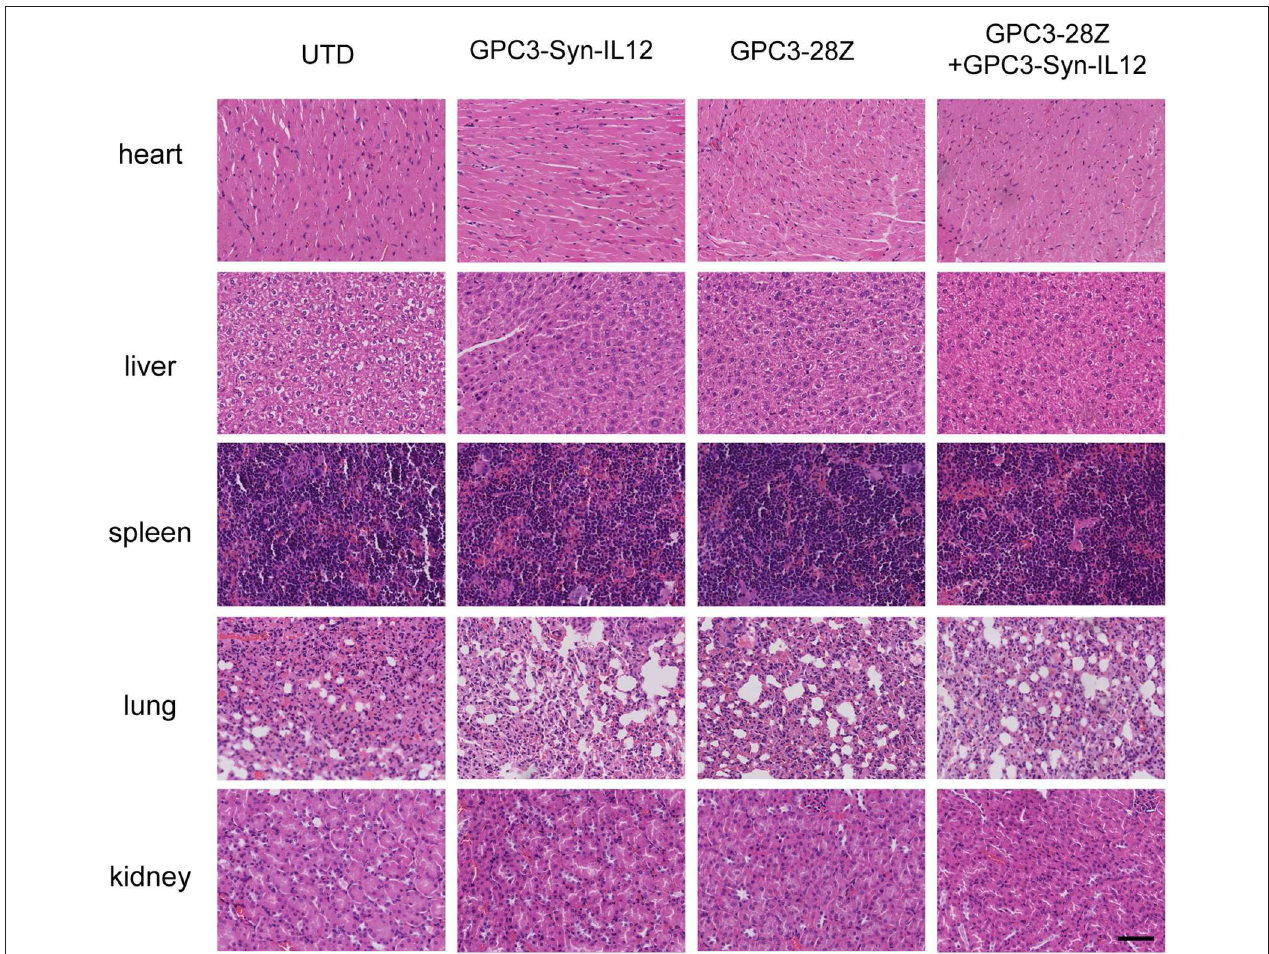
FIGURE 6 | Haematoxylin and eosin (HE) staining of important organs. Organs, including heart, liver, spleen, lung and kidney, were analyzed by HE staining. The specimens were harvested from Huh7-bearing mice sacrificed after study termination. The scale bar was 100 µ m. The data shown are representative of experiments with similar results. The images were obtained under 200 ×